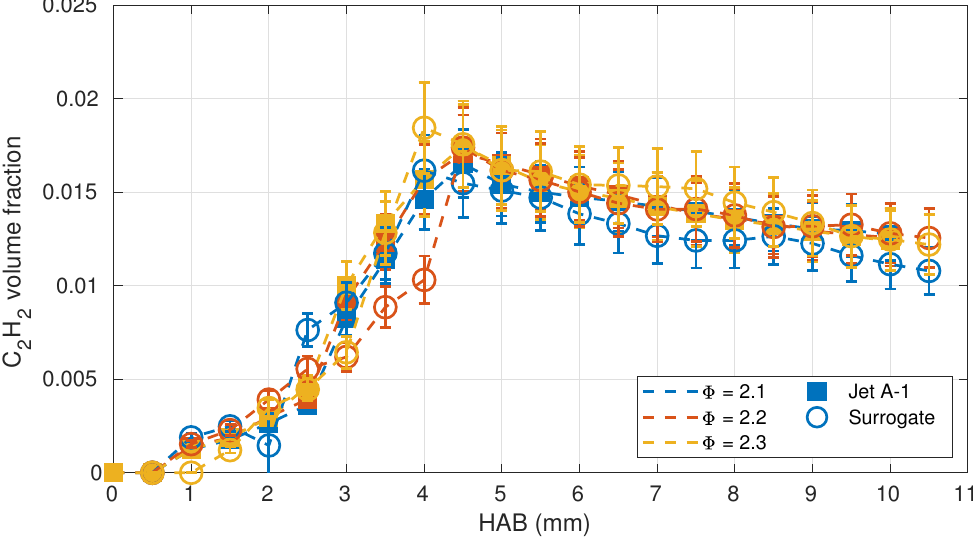
Figure 3. Profiles of acetylene concentration measured with TDLAS at 6 cm/s inlet velocity. In contrast to the previous findings, the measurements of the soot volume fractions show a different trend. Figure 4 shows the profiles of the soot volume fraction. Soot is detectable from 2 mm HAB and a clear dependency on the equivalence ratio is evident, with significantly higher volume fractions for the fuel-richer blends. In addition, there are also significant differences between the Jet A-1 and the surrogate. The maximum soot concentrations in the surrogate flames can be about twice as high as the concentrations found in the kerosene flames. For all investigated flames, the volume fraction increases steadily for increasing